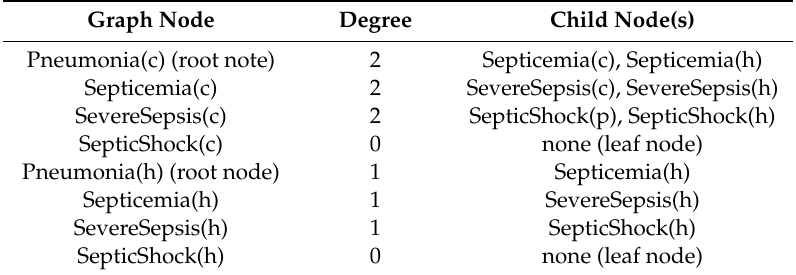
Figure 2 . Directed graph of pneumonia-induced bloodstream infection progression. Figure 2. Directed graph of pneumonia-induced bloodstream infection progression. Table 1. Graph nodes, their out-degree, and associated child Table 1. Graph nodes, their out-degree, and associated child nodes.